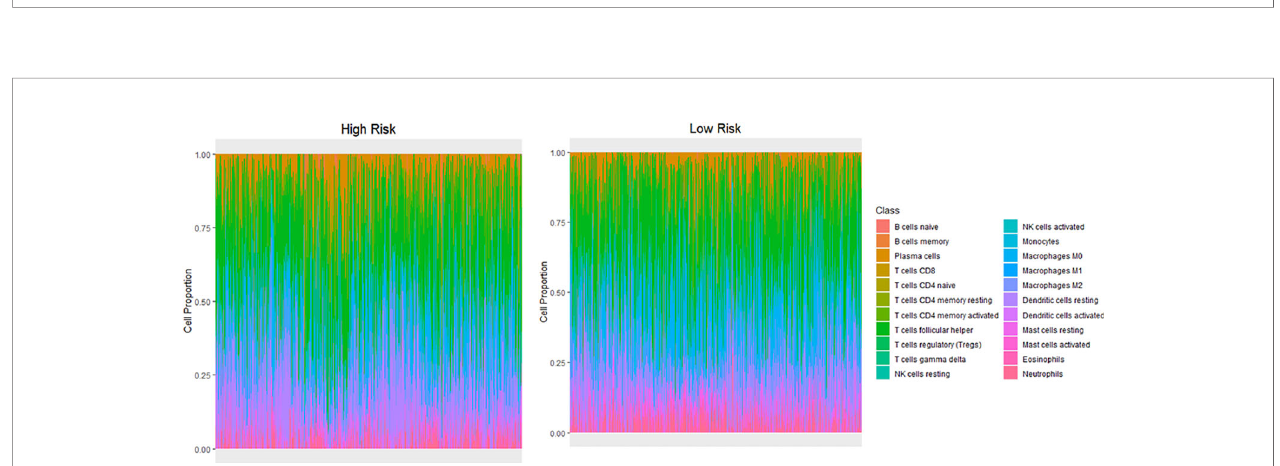
FIGURE 5 | Prognostic risk assessment model. (A) Tenfold cross ‐ validation for tuning parameter selection in the LASSO model; (B) Heat map analysis of the gene expression of six pseudogenes in the high- and low-risk groups.